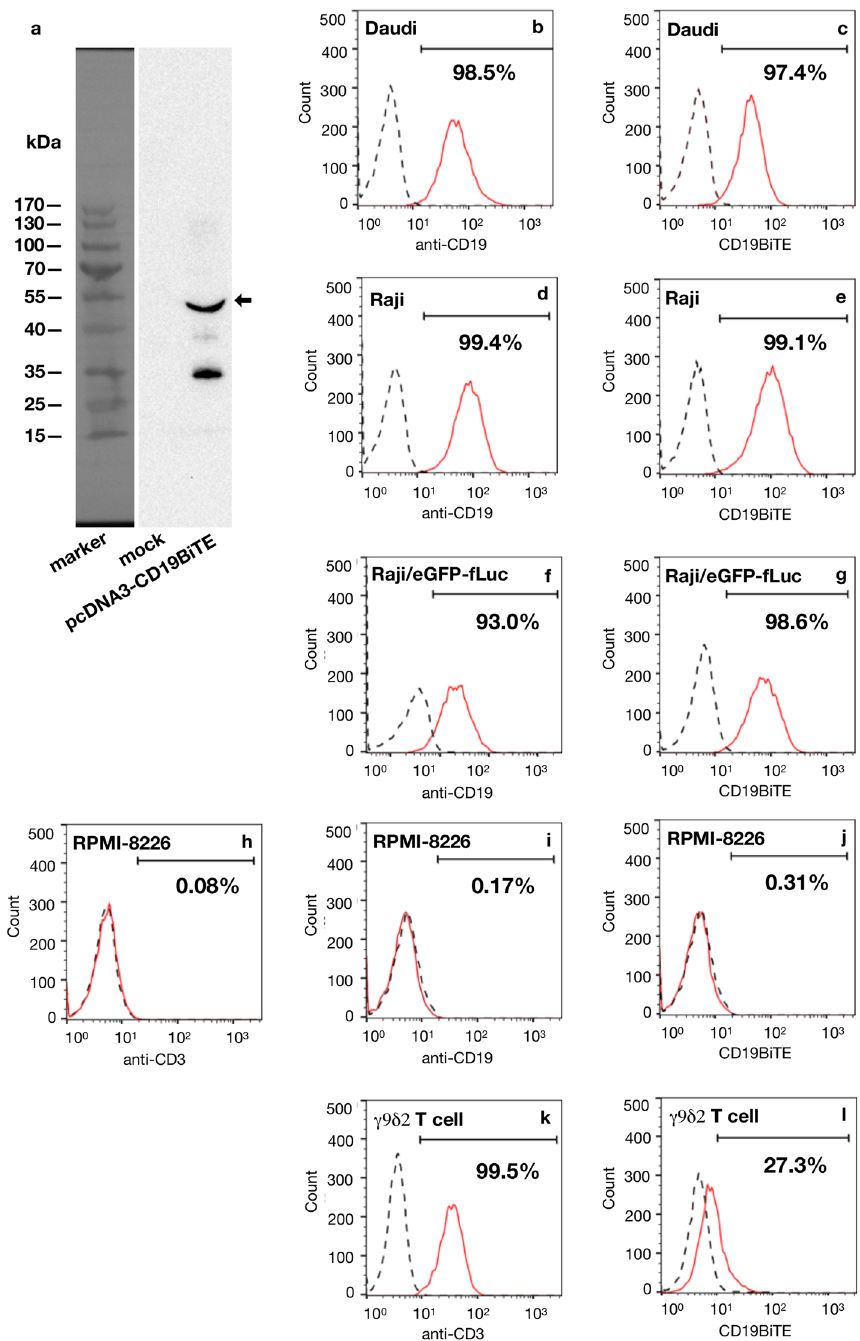
Figure 2. CD19BiTE binds to CD19-positive tumor cells and human γ9δ2 T cells. ( a ) HEK293 cells were transfected without (mock) or with the pcDNA3-CD19BiTE plasmid for 48 h, and then the culture media were subjected to protein purification by Ni-sepharose. The purified products were separated by SDS-PAGE and probed by an anti-6 × -histidine monoclonal antibody (mAb) in the Western blot analysis. A detected major band of the molecular weight of about 55 kDa similar to the predicted size of CD19BiTE was indicated (arrow). ( b – l ) Immunofluorescence histograms. Four tumor cell lines, Daudi ( b ), Raji ( d ), Raji/eGFP-fLu ( f ), and RPMI- 8226 ( i ), were stained without (dotted black line) or with a PE-labeled anti-CD19 mAb (solid red line). RPMI- 8226 ( h ) and expanded human γ9δ2 T cells ( k ) were stained without (dotted black line) or with an FITC-labeled anti-CD3 mAb (solid red line). Daudi ( c ), Raji ( e ), Raji/eGFP-fLu ( g ), and RPMI-8226 ( j ), and expanded human γ9δ2 T cells ( l ) were pre-incubated with (solid red line) or without (dotted black line) CD19BiTE (0.5 ng/µl) and then stained with a PE-labeled anti-6 × -histidine mAb. The stained cells were analyzed on a flow cytometer, and data were presented as histograms with counts versus fluorescence. The percentage of cell populations with fluorescence intensity higher than the background value was indicated. Images were created using FlowJo software